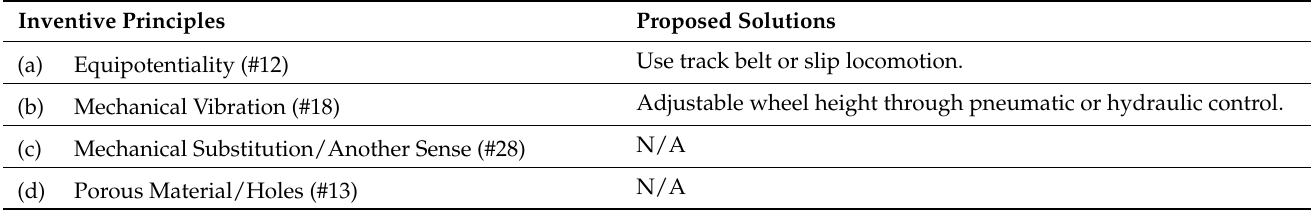
Table 9. Proposed solutions based on principles from of parameters #19 and #1 within the contradic- tion matrix.